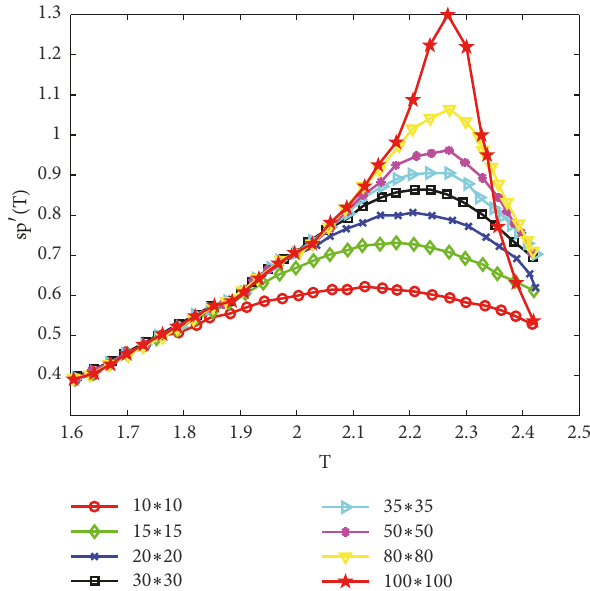
Figure 4: Variation of von Neumann entropy derivative 𝑆 𝑝󸀠 (𝑇) of different systems with temperature 𝑇